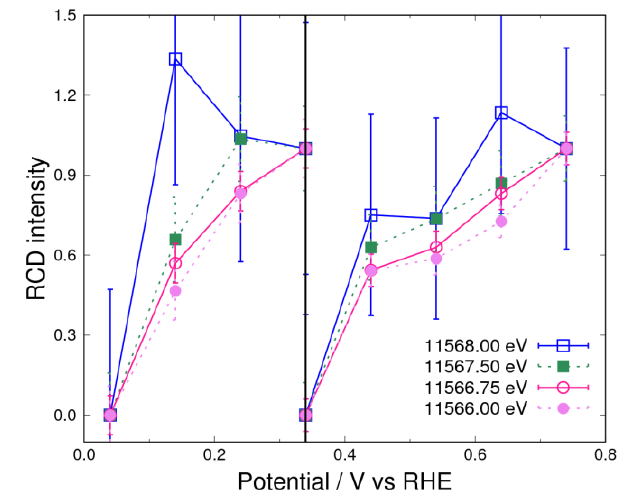
Figure 6. RCD curves for the controlled potential below 0.74 V in 1 M of KOH saturated with O 2 . The standard potentials are 0.04 V, 0.34 V, and 0.74 V. The circle and square curves represent the negative and positive peak of 11,566.75 eV and 11,567.5 eV, respectively. The dashed lines complement the explanation for RCD.